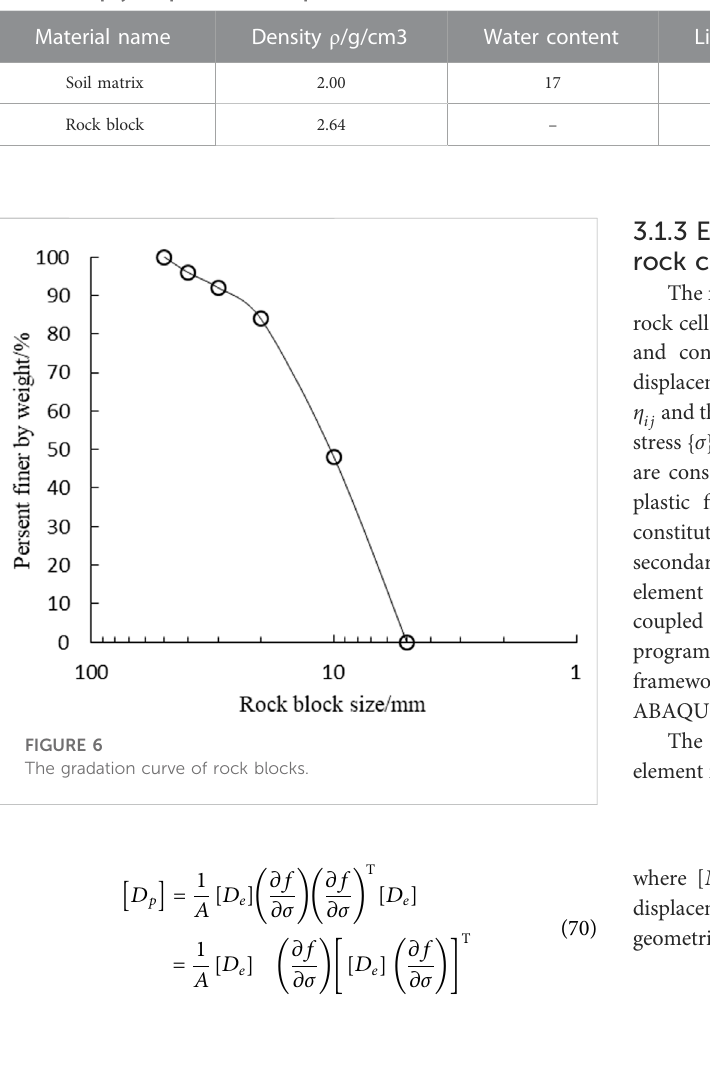
TABLE 1 The physical parameters of experiment materials.